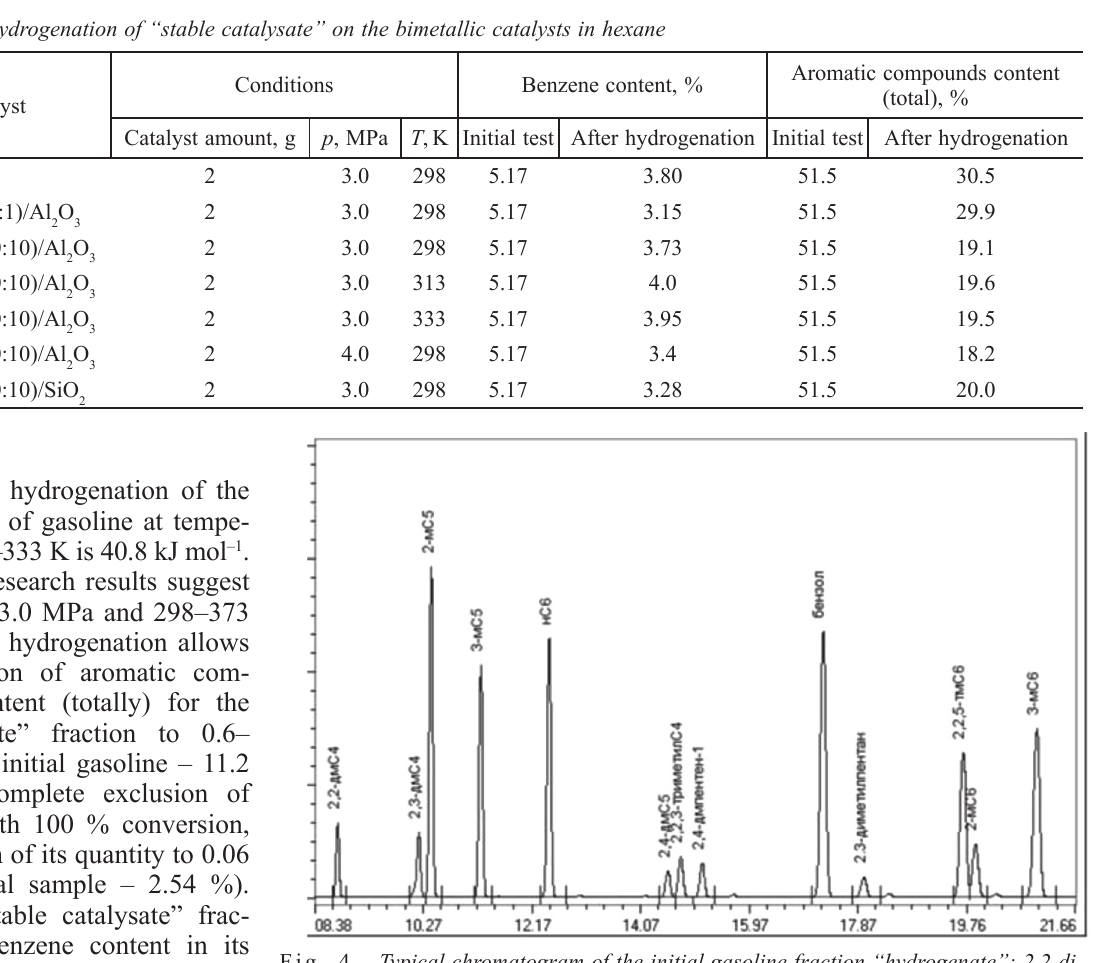
Fig. 4 – Typical chromatogram of the initial gasoline fraction “hydrogenate”: 2.2-di- methyl C